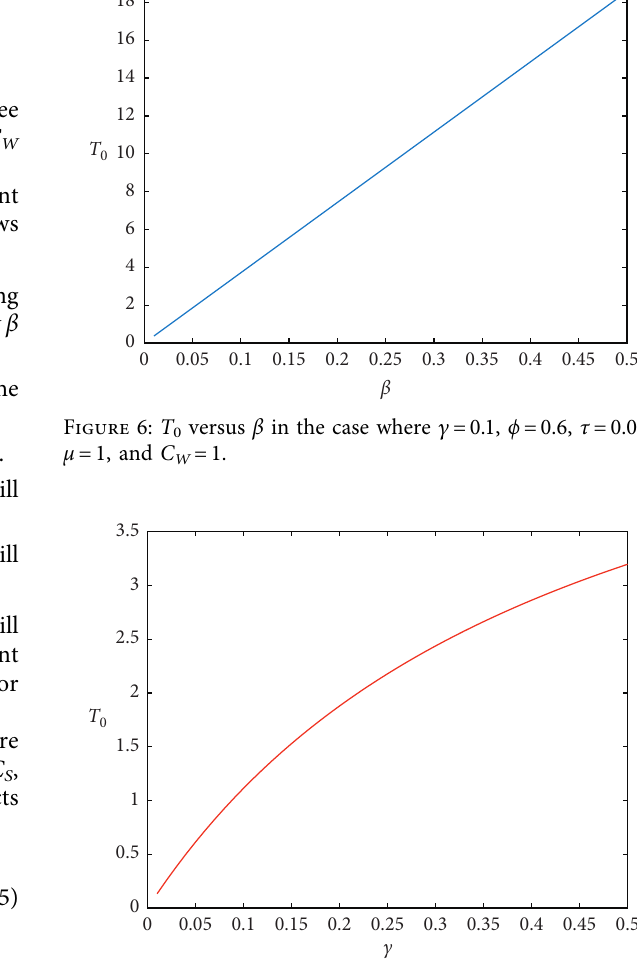
Figure 7: T c in the case where β � 0.03, ϕ � 0.6, τ � 0.005, 0 versus μ � 1, and C W �